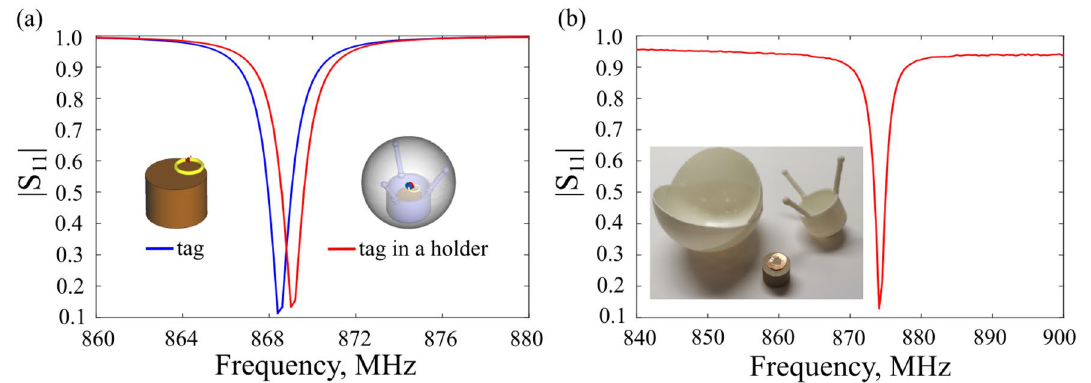
Figure 3. ( a ) Numerical |S 11 | spectra of the ceramic tag in free space and within the roly-poly holder. The impedance of the port is equal to the value provided by the vendor (Impinj Monza R6). The inset shows the structures. ( b ) Experimental |S 11 | spectrum of the fabricated ceramic resonator, measured by a small magnetic probe. The inset shows the components of the proposed RFID